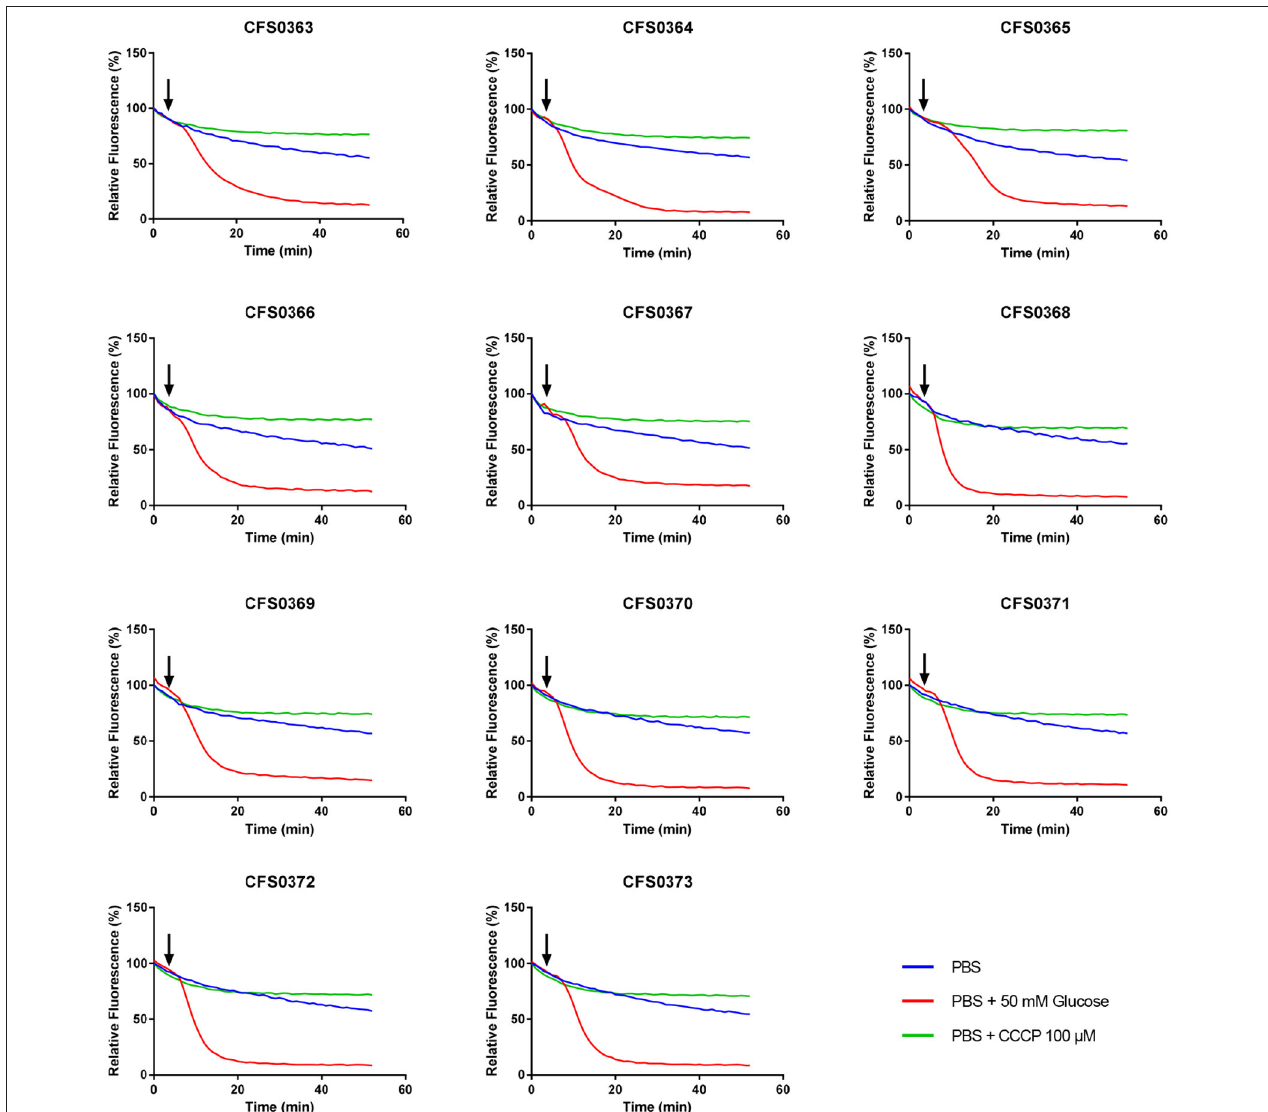
FIGURE 3 | Determination of the ethidium bromide efflux by a semi-automated fluorometric method. Klebsiella pneumoniae isolates were saturated with 50 µ M ethidium bromide and efflux measured by fluorometry at 37 ◦ C for 50 min with an excitation and emission wavelengths of 518- and 606-nm, in the presence or absence of glucose and CCCP. Black arrows indicate when glucose (50 mM) was added after 3 min of initial